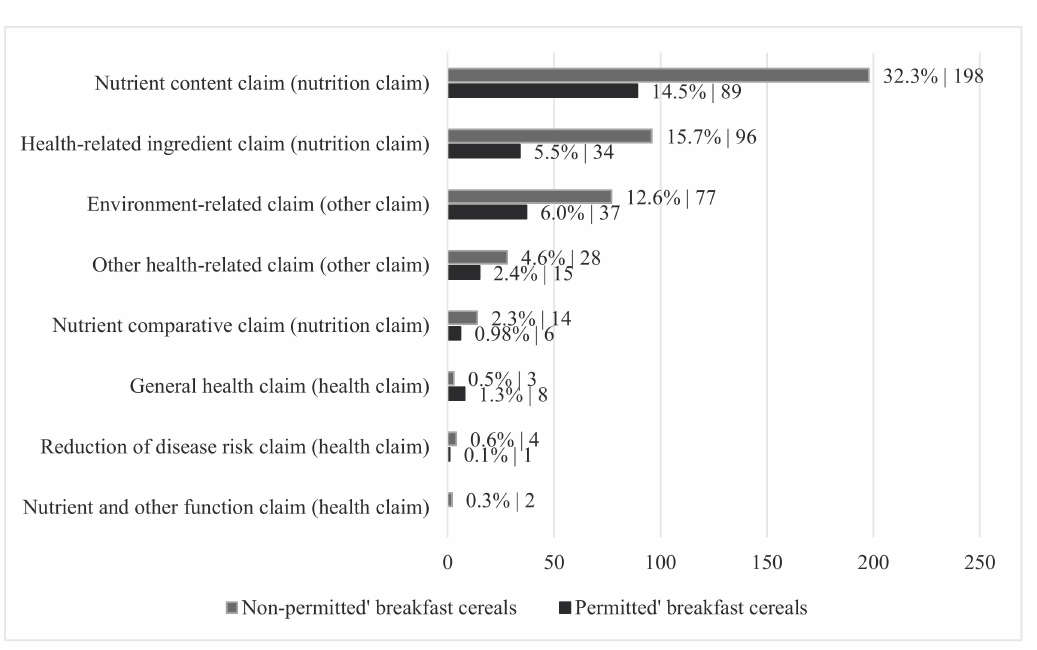
Figure 1. Di ff erent types of claims displayed on breakfast cereals on the Belgian market (2018) permitted or not permitted to be marketed by the WHO Europe nutrient profile